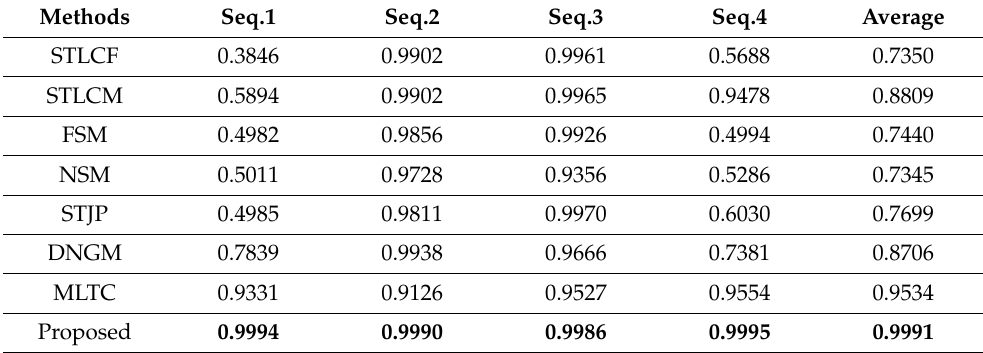
Table 4. AUC values of different methods. The last column shows the average